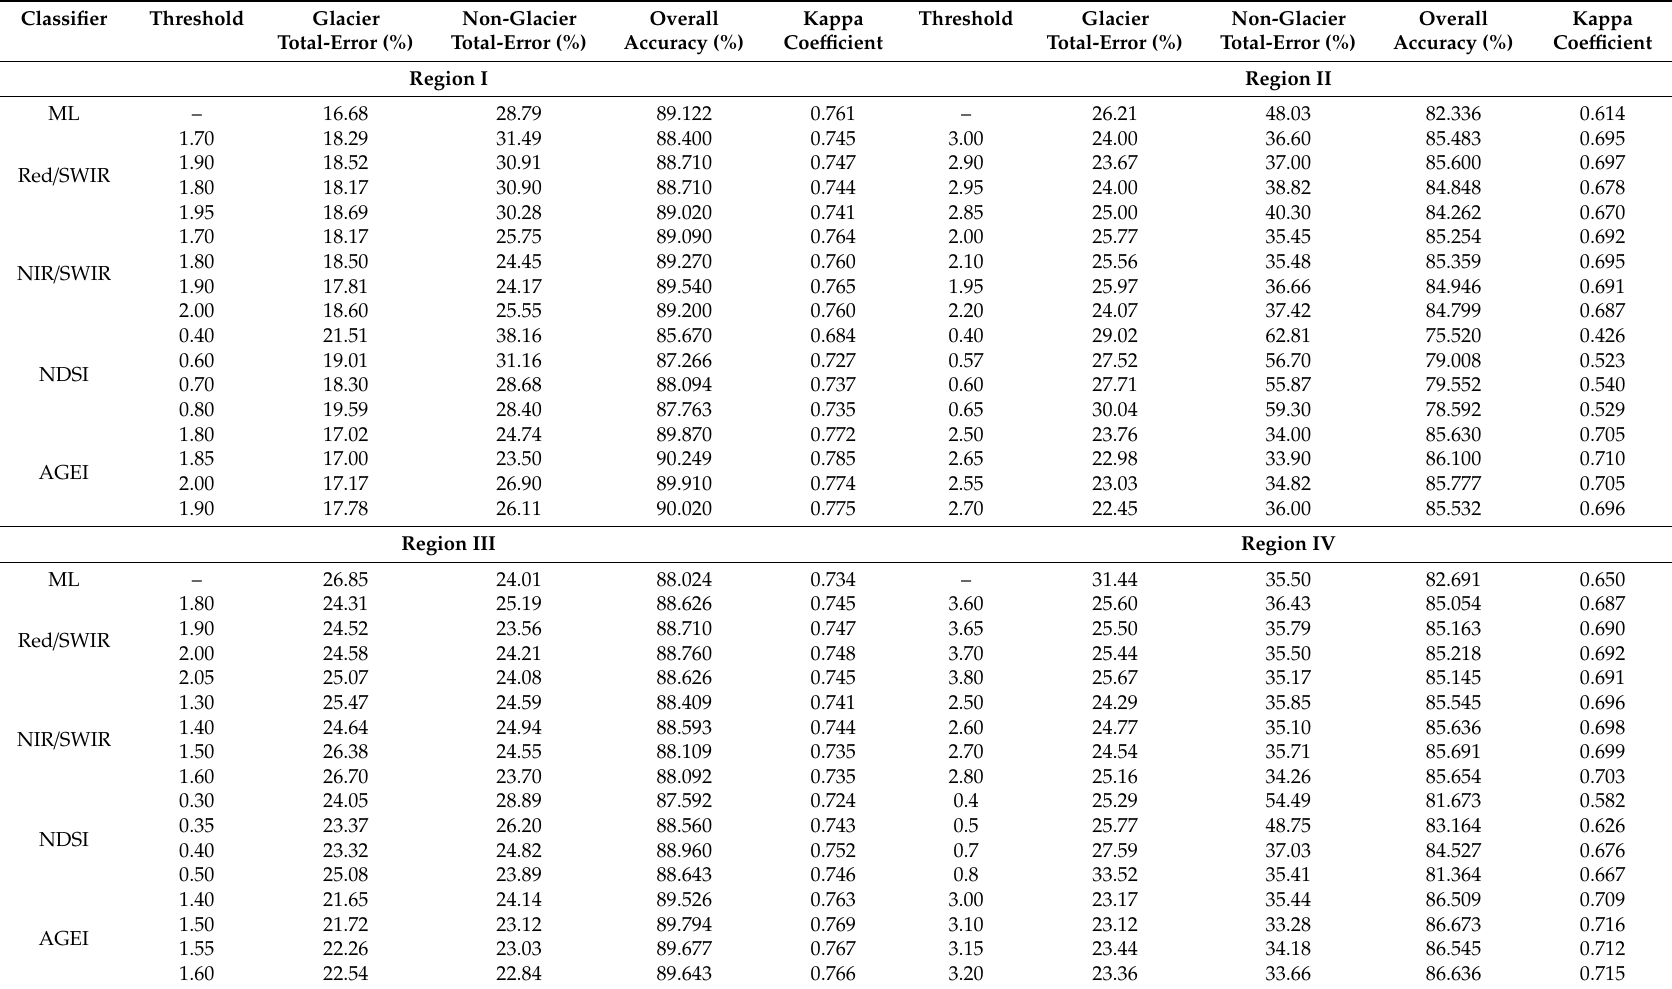
Table 3. Summary of per-pixel accuracy for five classifiers in the four test